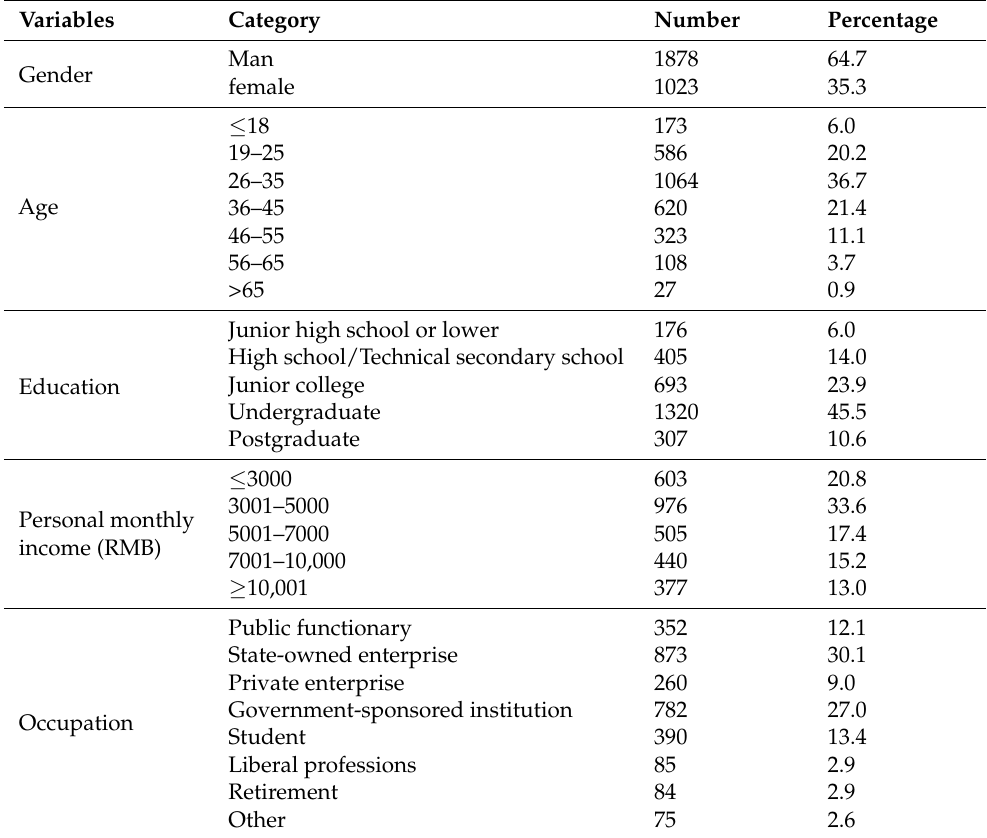
Table 1. The demographic characteristics of the